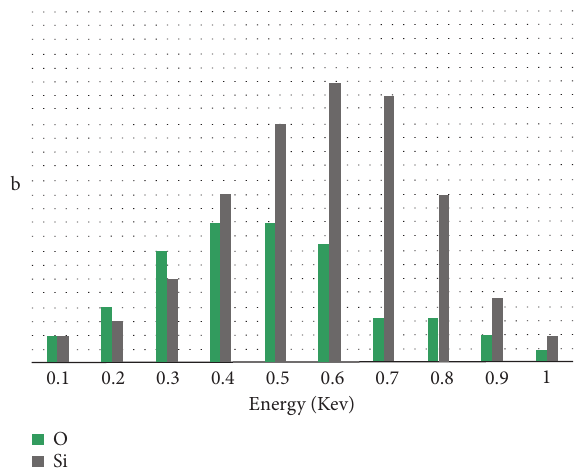
2 nanowires and nanoparticles.